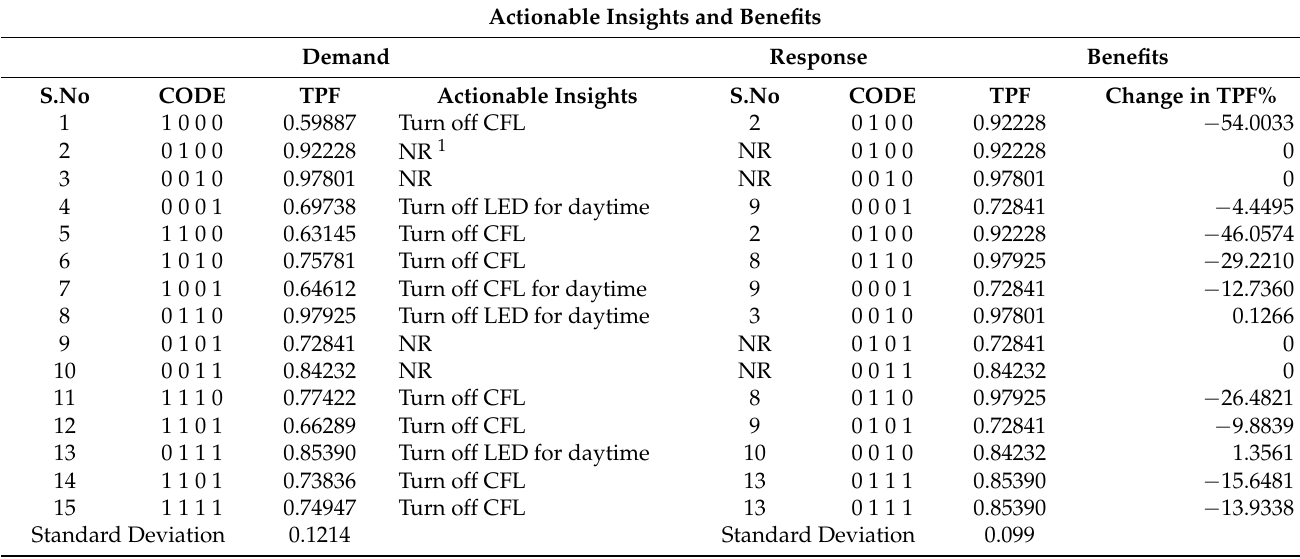
Table 3. Actionable insights for DR management using the TPF.